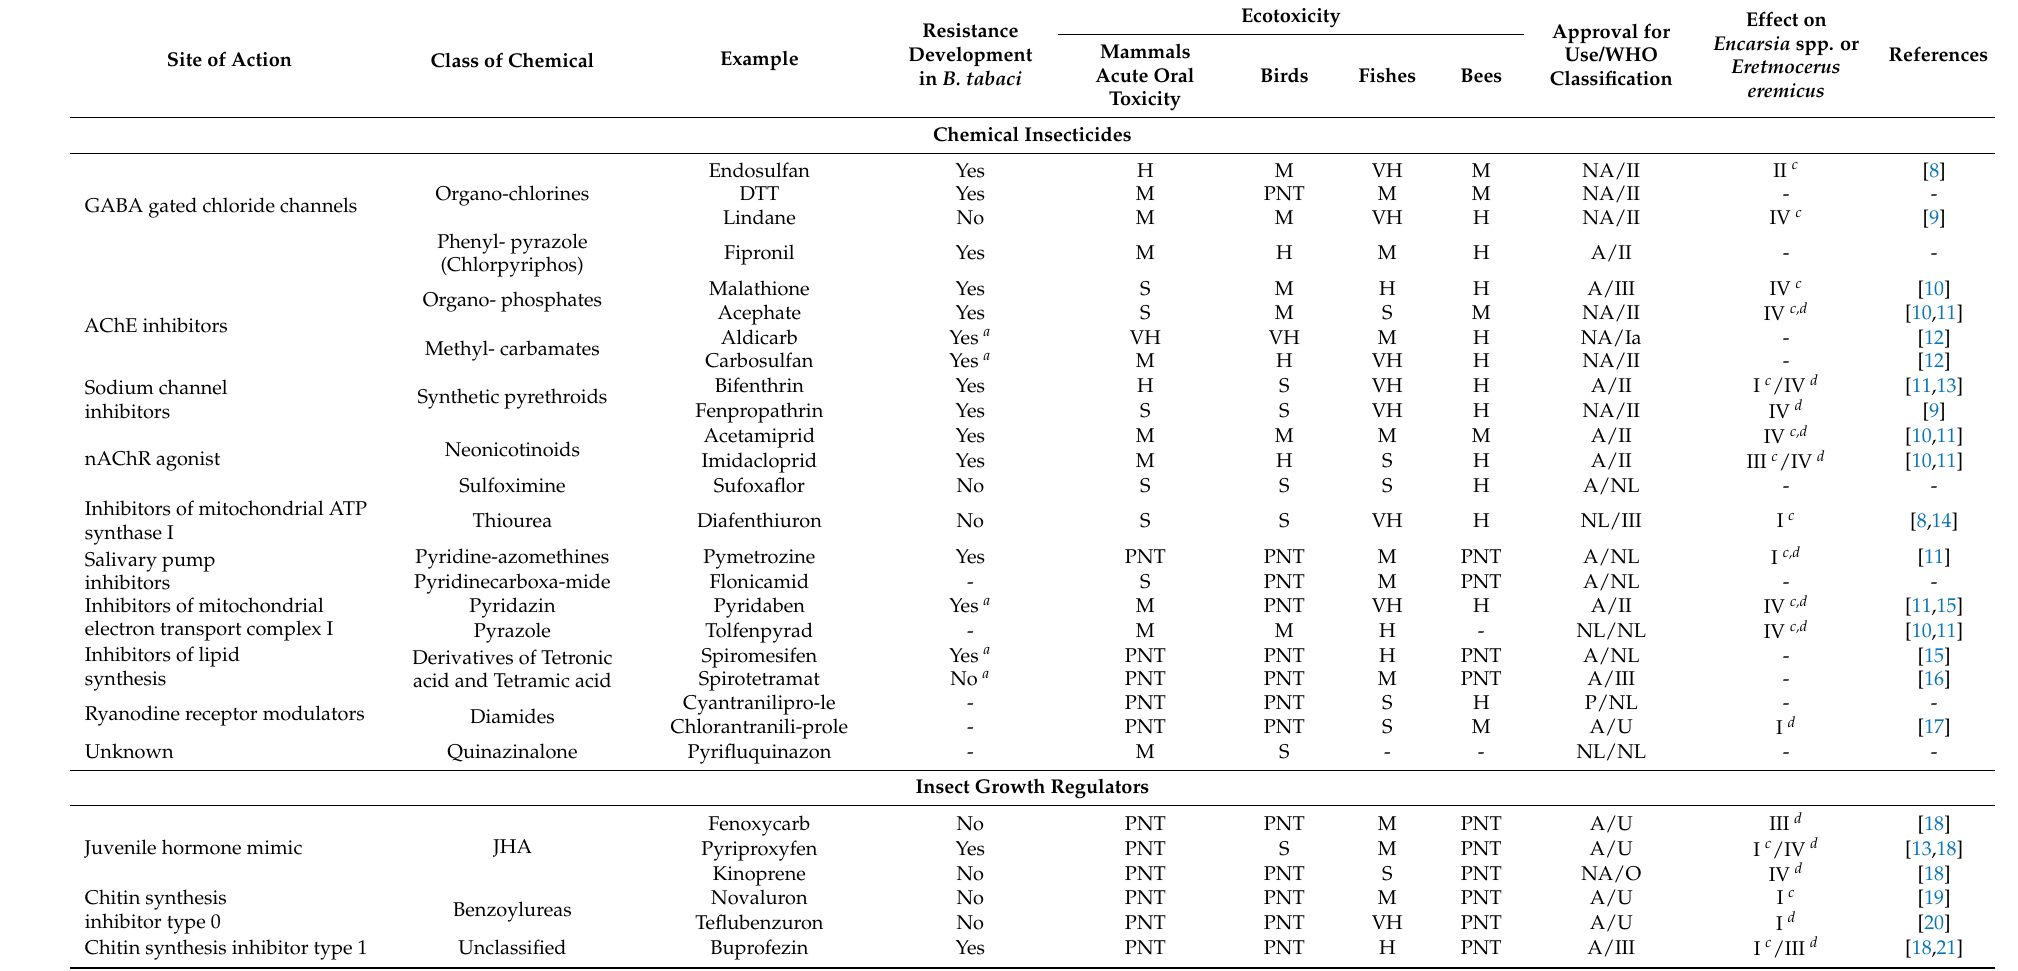
Table 1. Widely used insecticides with reported efficacy against